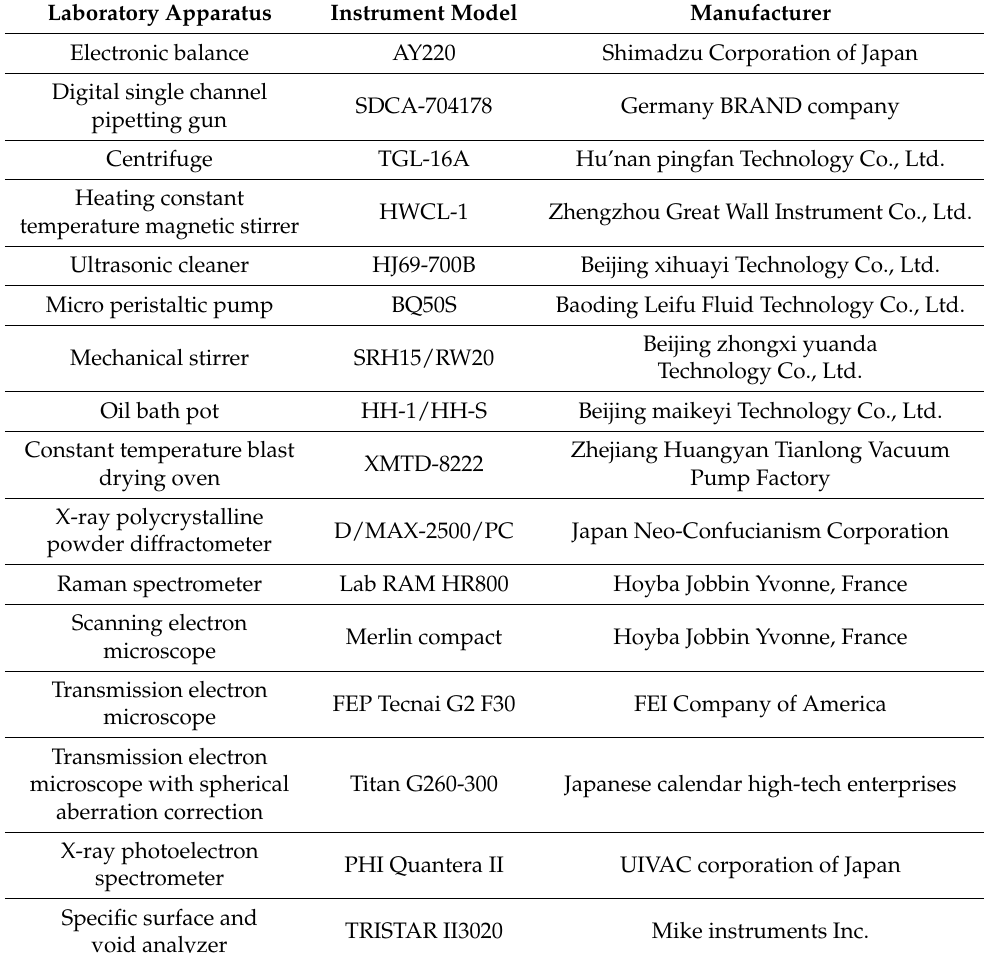
Table 1. Instruments of the